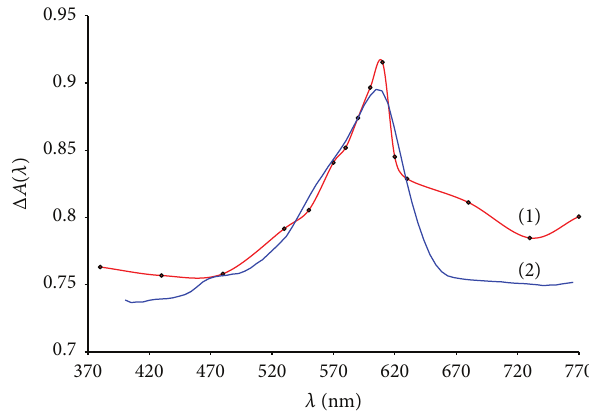
Figure 1: Absorption (1) spectrum obtained on “Phototest” with filter kit and diffusion reflectance (2) spectrum obtained on “SF- 2000 Bio” with diffusion reflectance add-on